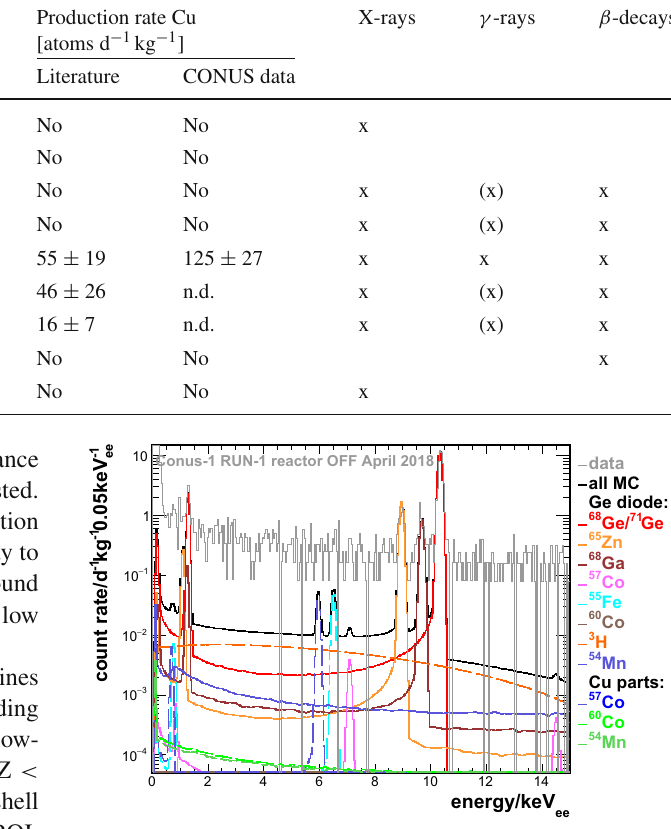
Table 3 Production rates at sea level of all cosmogenic isotopes in Ge and Cu relevant for CONUS. For the literature values, mean val- ues and standard deviations are stated (see [24–34] for Ge and [35] for Cu) except for 3 H. For 3 H, the mean value was calculated from the rates determined in [32–34], but the uncertainty evaluated by the EDELWEISS experiment is used [32]. From the lines visible in the